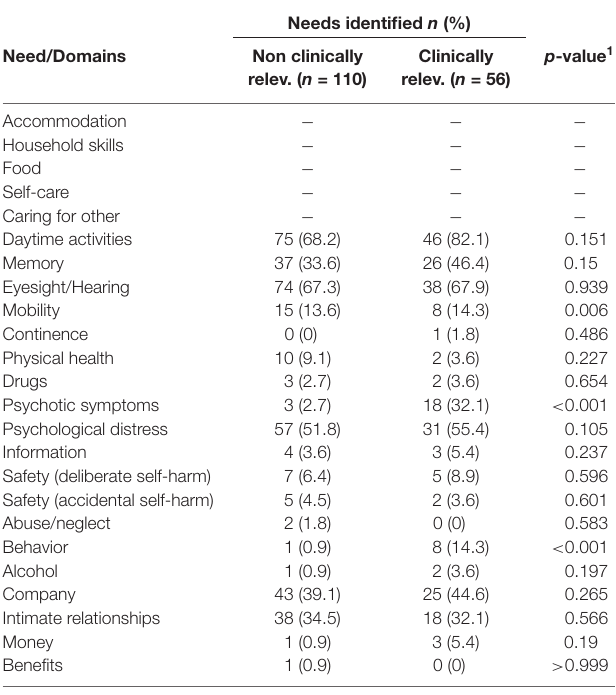
TABLE 7 | Unmet needs considering behavioral and psychological symptoms